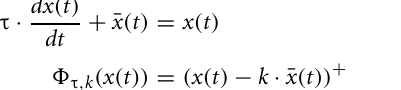
( t ) and r j ( t ) are the pre- and post-synaptic where r i post pre